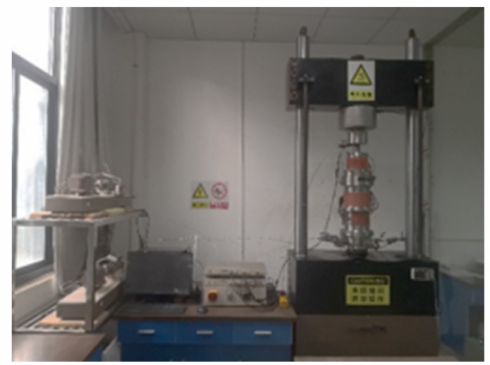
Figure 5. The High-pressure triaxial testing